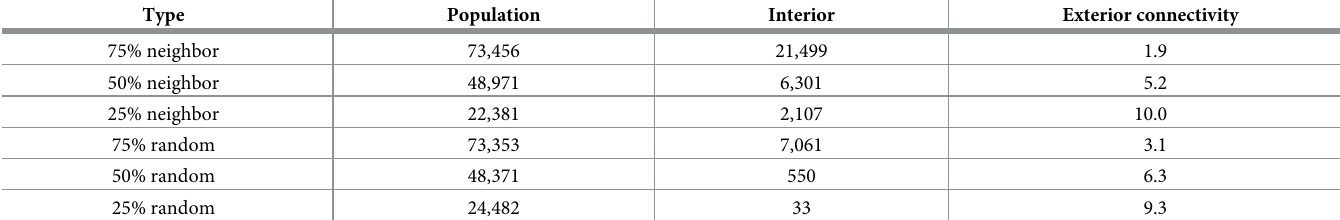
Table 2. Details of the different user bases. The percentage represents approximately ~ N = N , for the user population ~ N . The interior defines how many users are completely surrounded by other users. The exterior connectivity gives the average number of exterior nodes connected to a node inside the user